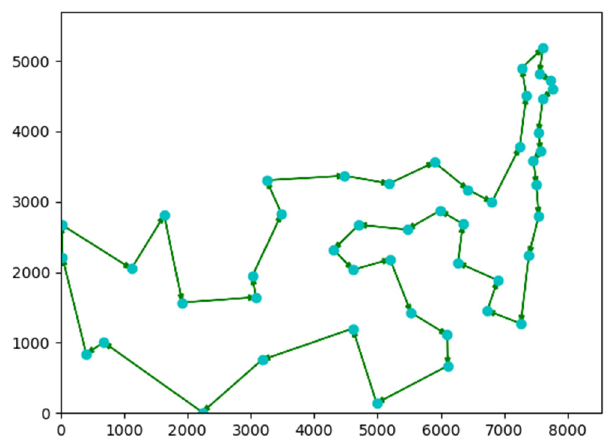
Figure 16. DTLBO solution for Att48.